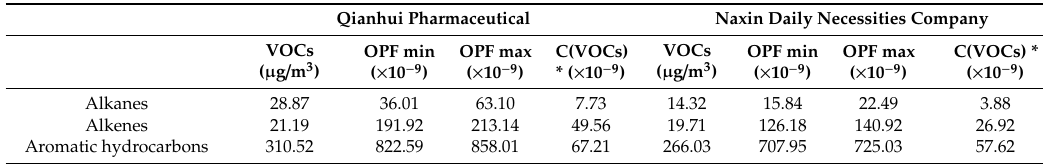
Table 2. The different VOC contents, the ozone formation potential (OFP) values, and equivalent propylene concentrations in the two study areas.